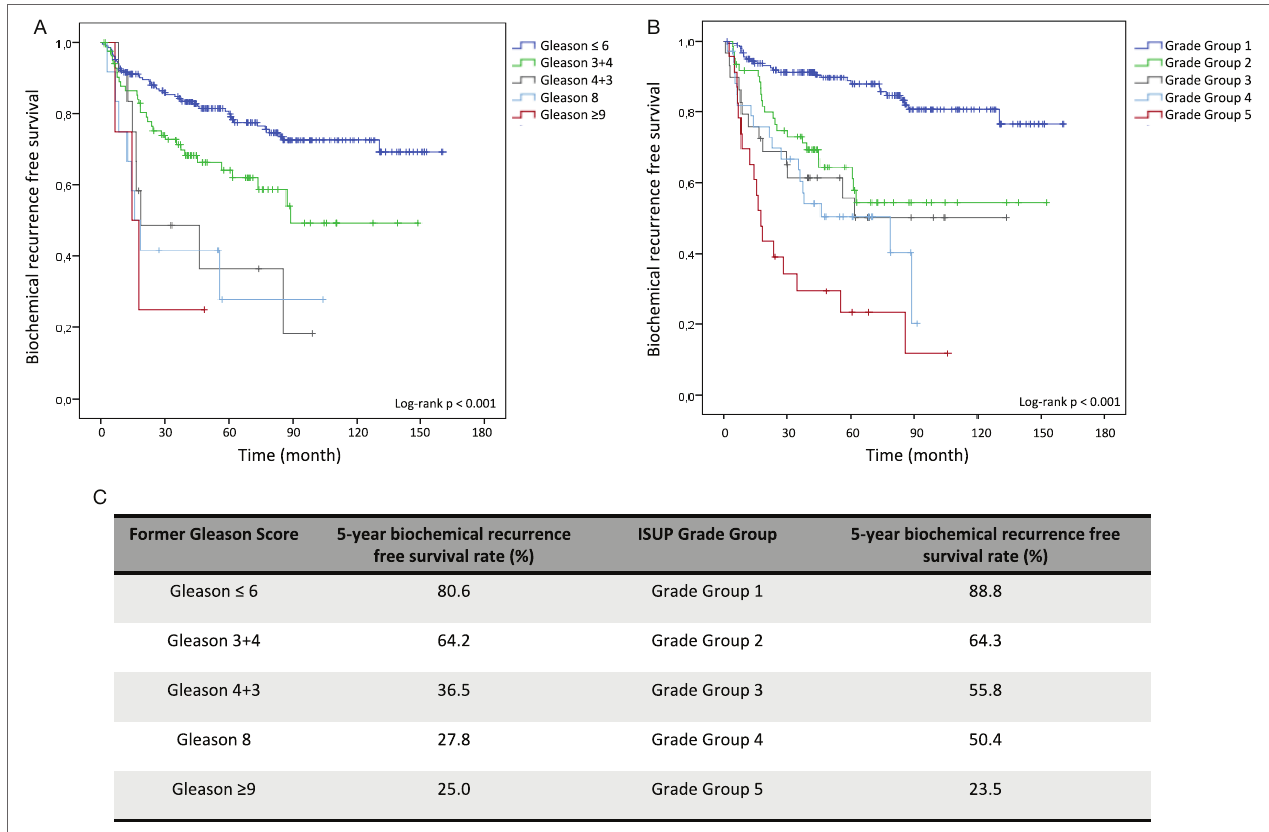
FigUre 2 | Kaplan–Meier analysis for biochemical recurrence free survival (BFS) according to the former Gleason Grading and International Society of Urological Pathology (ISUP) Grade Groups on diagnostic biopsies. (a) BFS stratified by Gleason ≤ 6, Gleason 3 + 4, Gleason 4 + 3, Gleason 8, and Gleason ≥ 9. (b) BFS stratified by Grade Group 1, Grade Group 2, Grade Group 3, Grade Group 4, and Grade Group 5. (c) 5-year BFS rate in% for grading according former Gleason Grading or ISUP Grade Group.